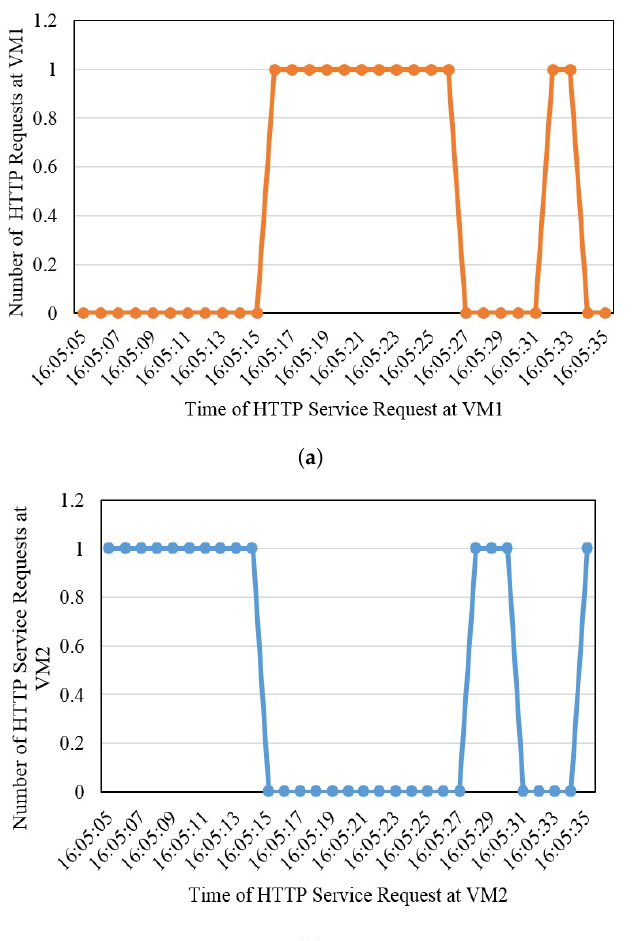
Figure 8. Antifragility and resiliency at VM level, ( a ) Virtual machine 1 status, and ( b ) Virtual machine 2